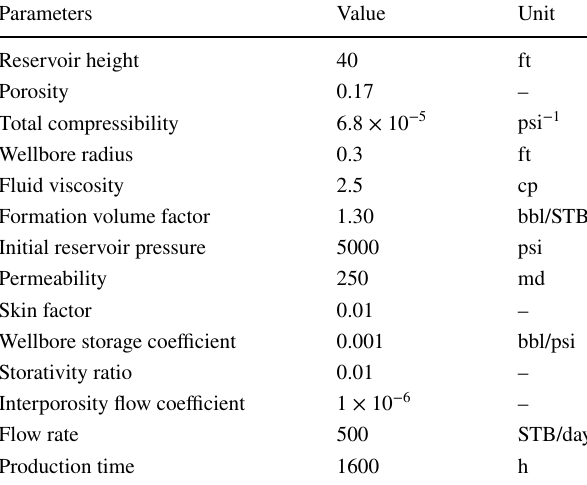
Table 1 Model properties for generation of synthetic pressure data Parameters